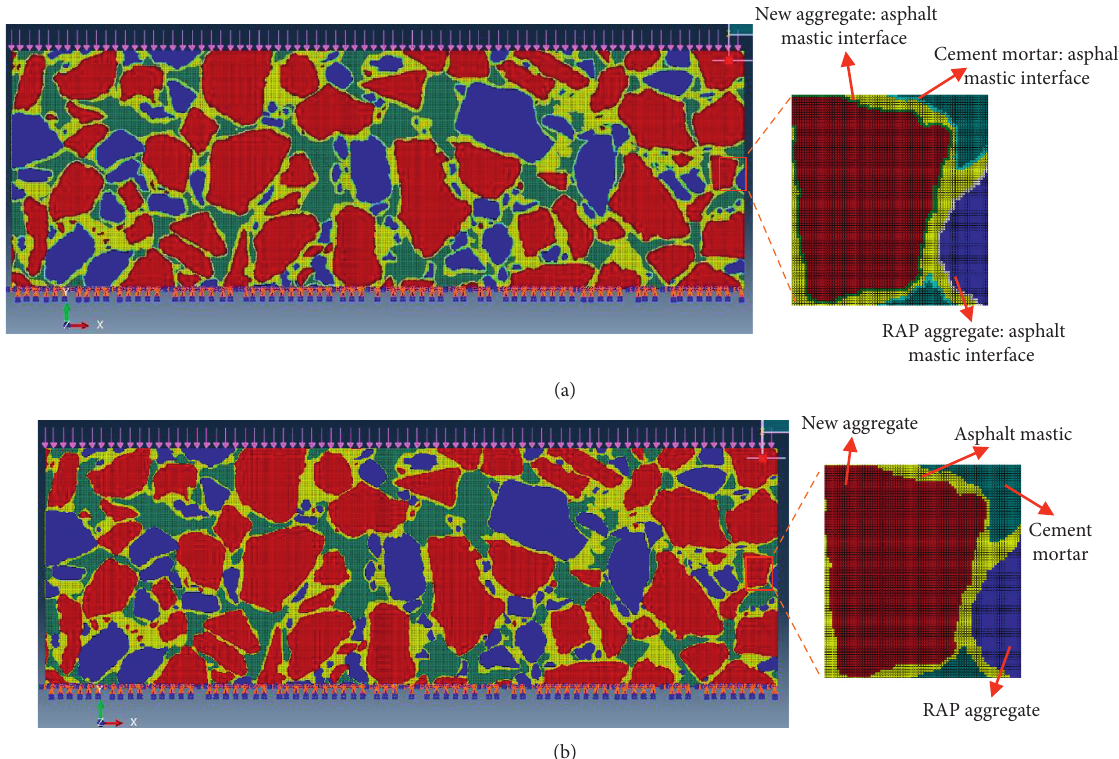
Figure 5: Reconstruction of semiflexible pavement material using the finite element method: (a) model with interface; (b) model without